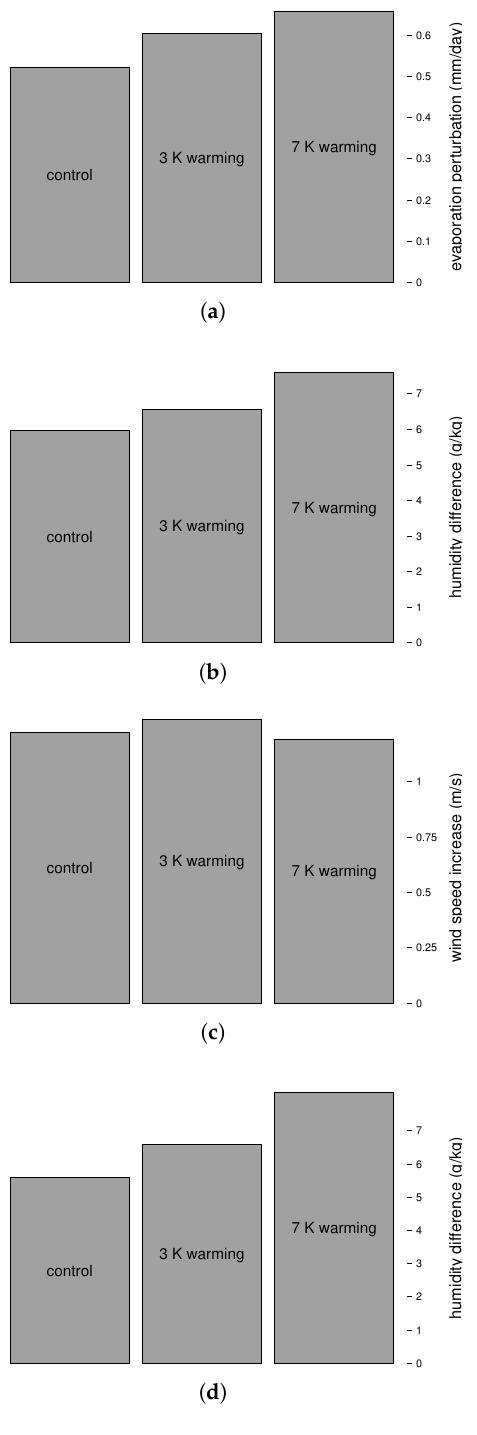
Figure 12. Sensitivity of: ( a ) evaporation; ( b ) specific humidity difference between water surface and atmosphere; and ( c ) wind speed to ocean warming. For each panel, average values are shown for the region outlined with a dotted green line in Figure 9. Panel ( d ) shows the specific humidity difference that would occur if the lower atmospheric relative humidity and air–sea temperature difference were held constant across the simulations (i.e., how the specific humidity difference changes owing to the nonlinear nature of the Clausius–Clapeyron